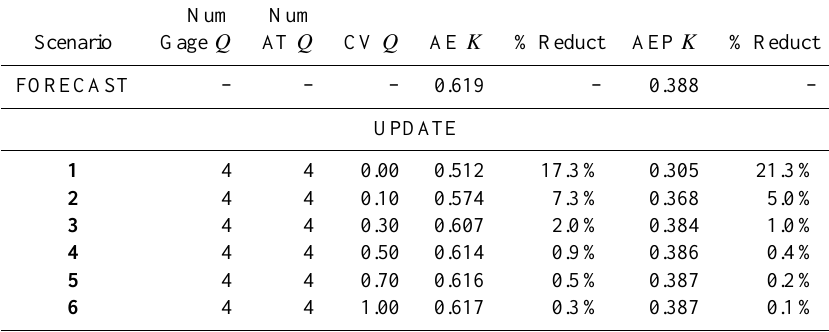
Table 2. The increase of AE (i.e., the decrease in conditioning to the true Y K field) with increasing values of CV of the WT observation data, for the cases when one, two, and four assimilation times are used.